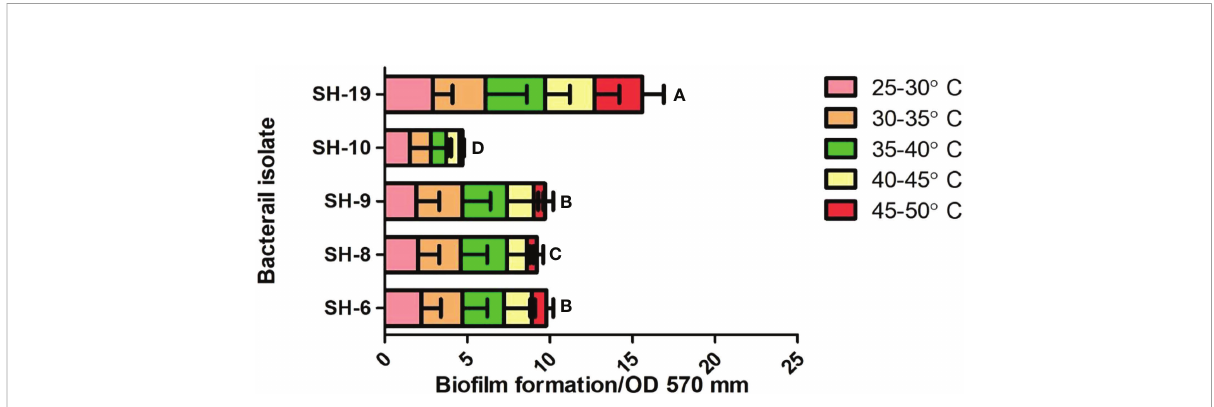
FIGURE 3 Bio fi lm information by the fi ve selected isolates on 96-well polystyrene microplates under 22 – 50°C for 24 h. The letter on each bar is the signi fi cant different between treatments at P ≤ 0.05. The error bar represents the standard error among the replicates.